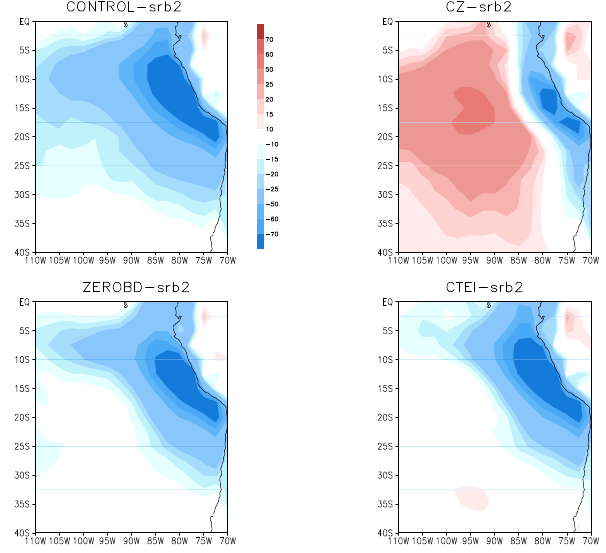
Fig. 6. The ensemble July 2008 mean surface downward shortwave radiative flux errors (differences between the four simulations and SRB climatology).